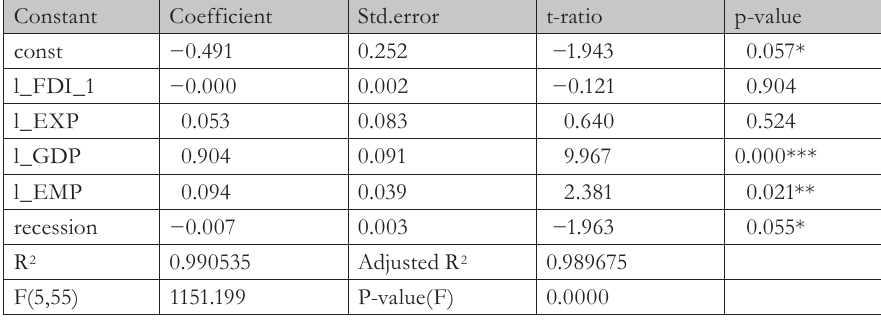
Tab. 6 – VAR foreign direct model with GDP as dependent variable. Source: own